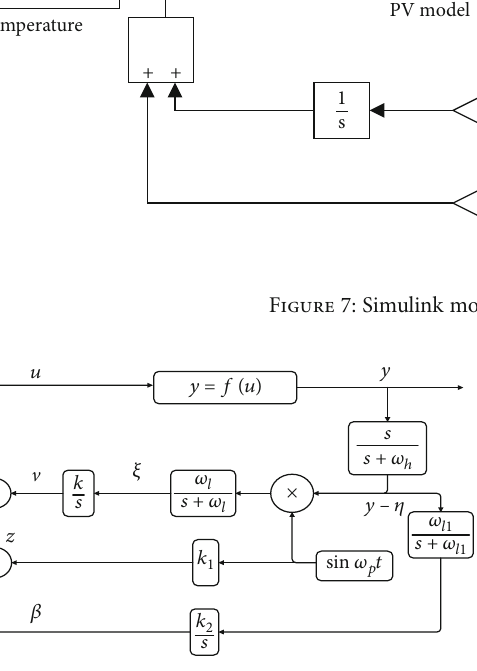
Figure 8: Modi fi ed ESC